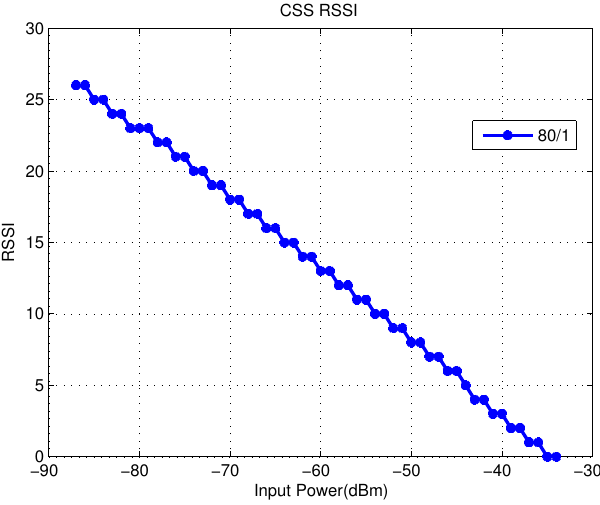
Figure 3. Chirp spread spectrum (CSS) received signal strength indicator (RSSI) vs . input